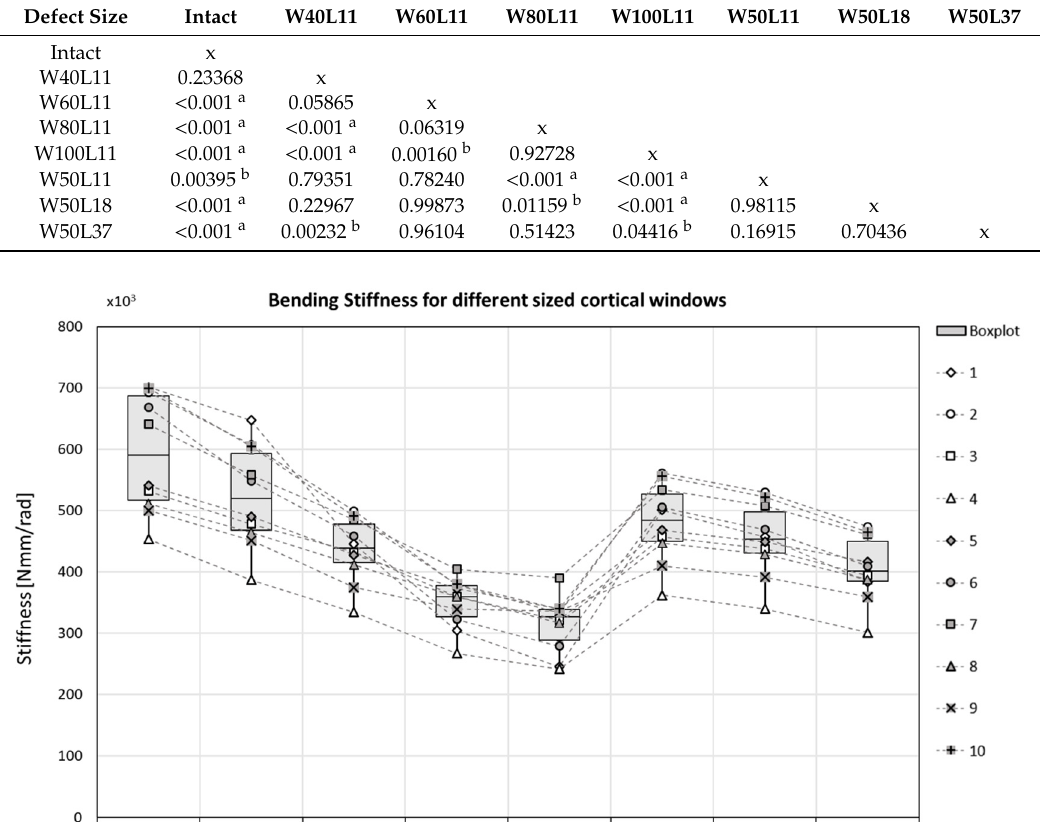
Table 3. Pairwise comparison (Welch’s test with Tukey correction) of the bending sti ff ness of bones with varying cortical defects leads to many statistical di ff erences: a p -value < 0.001 and b p -value < 0.05.